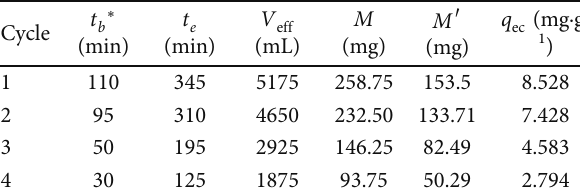
Table 6: Adsorption parameters acquired by fi xed-bed column adsorption in four adsorption – desorption